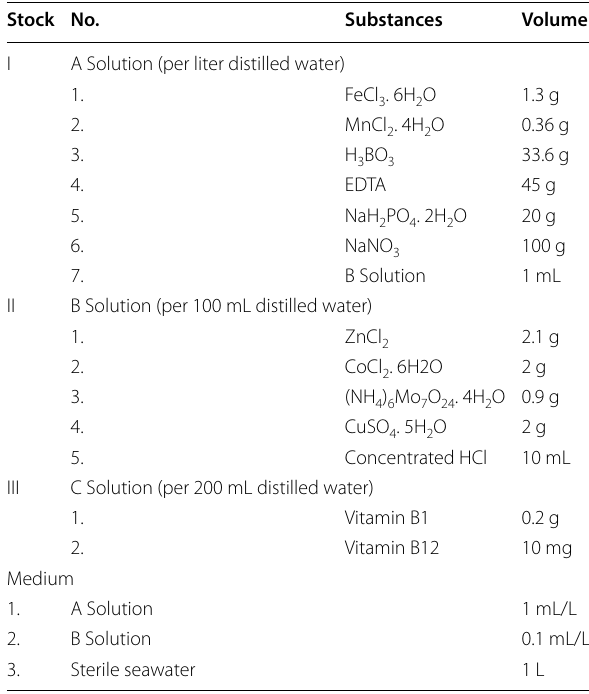
Table 1 Walne medium composition (Anderson 2005; Oo